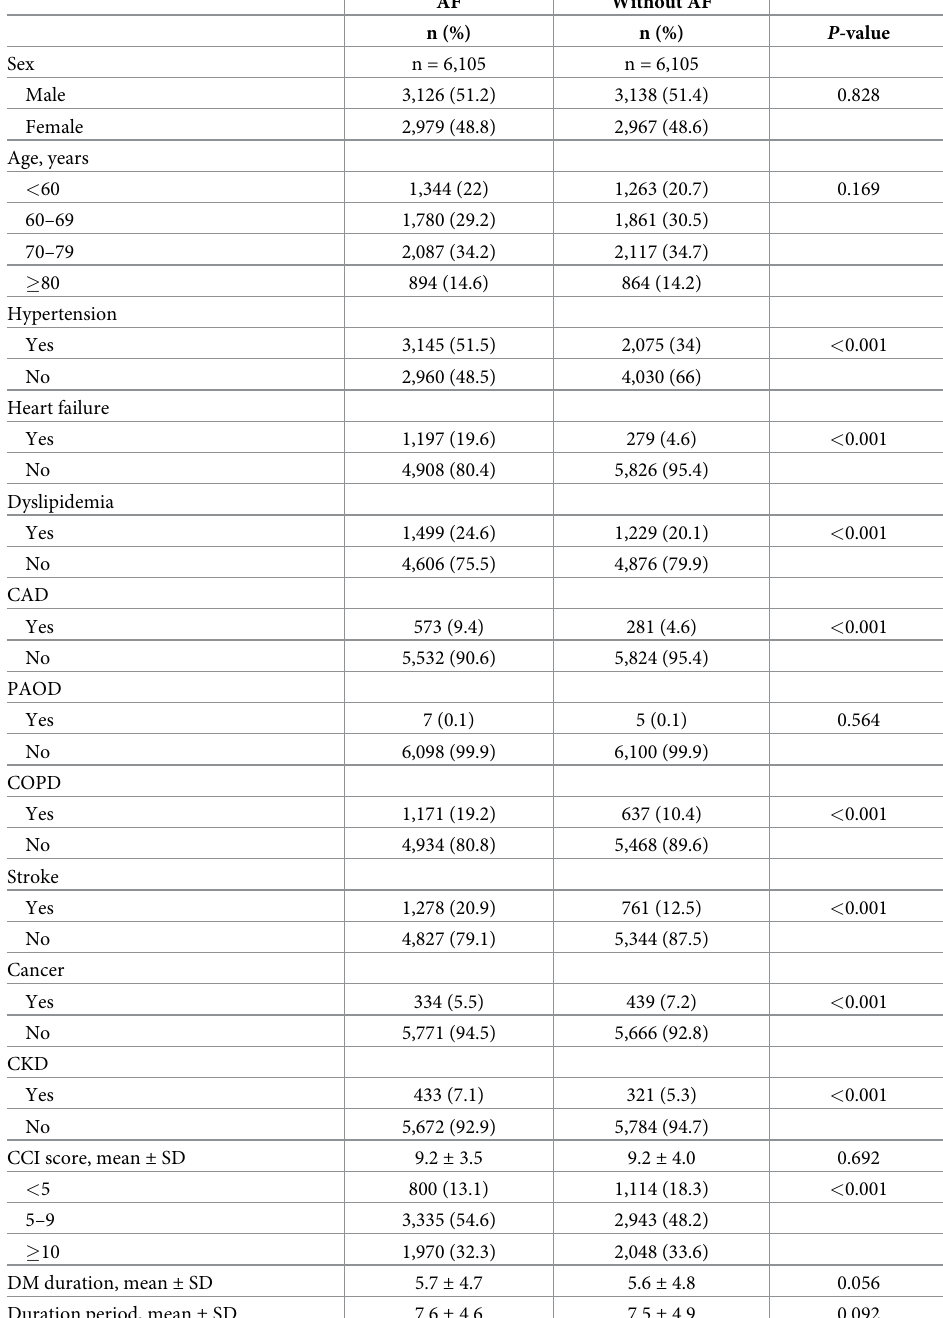
Abbreviations: AF, atrial fibrillation; CAD, cardiac artery disease; CCI, Charlson Comorbidity Index; CKD, chronic kidney disease; COPD, chronic obstructive pulmonary disorder; DM, diabetes mellitus; PAOD, peripheral arterial occlusive